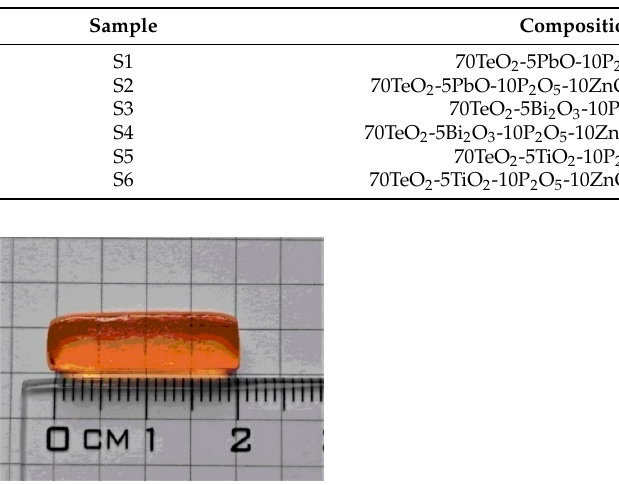
Table 5. The chemical composition of the investigated tellurite glass systems.